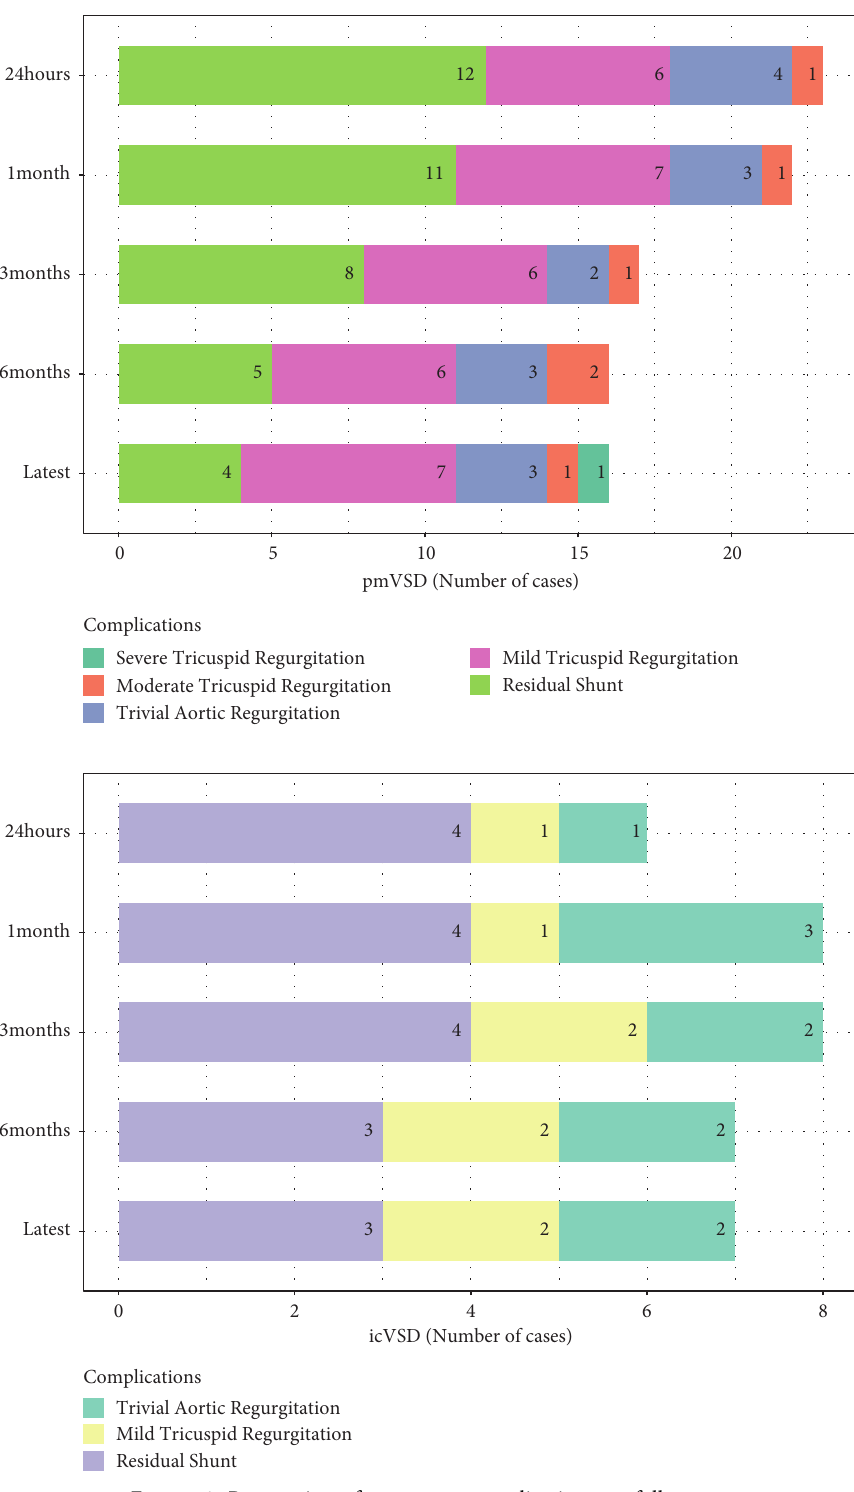
Figure 2: Progression of new-onset complications on